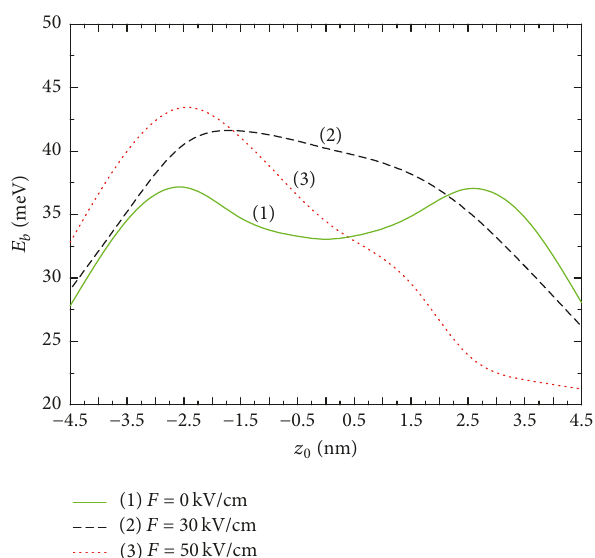
Figure 6: The ground-state donor binding energy 𝐸 𝑏 in a ZB In 𝑥 Ga 1−𝑥 N/GaN symmetric coupled QDs as a function of the impurity position 𝑧 0 for 𝑅 = 10 nm, 𝐿 lw = 4 nm, 𝐿 mb = 1 nm, 𝐿 = 4 nm, 𝜌 = 0 for different external electric field F = 0, rw 0 30 kV/cm, and 50